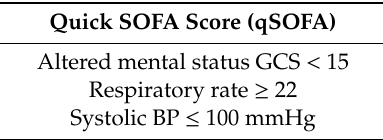
Table 3. Quick Sequential Organ Failure Score